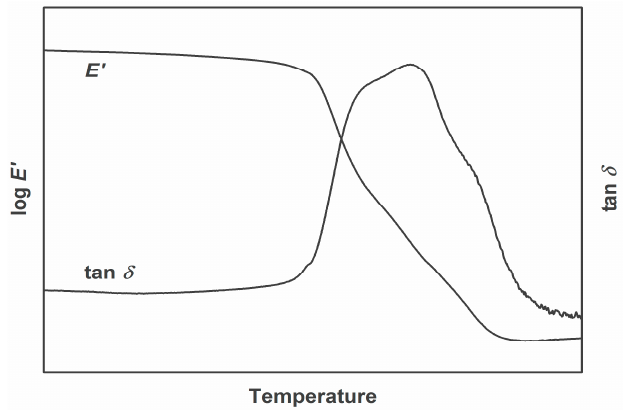
Figure 4. Representative DMA curve of an inhomogeneous thermoset.